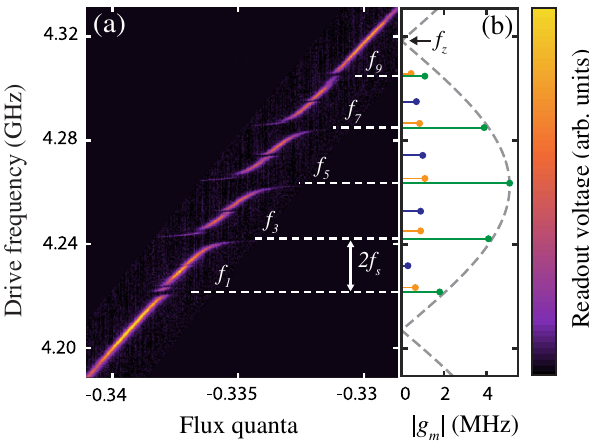
FIG. 2. Avoided crossings spectroscopy. Tuning the qubit across the cavity modes measures the mode frequencies and qubit-cavity coupling strengths. (a) Within the mirror bandwidth, 9 avoided crossings appear with varying coupling strength and a ¼ 10 . 6 MHz. The strong avoided nearly even mode spacing, f s crossings have a spurious mode on their high-frequency shoulder, which we attribute to a resonance with nonzero transverse mode number. (b) The coupling strengths to each mode are extracted from the measured crossings. The qubit couples more strongly to modes at the center of the mirror band with maximum strength g 0 ¼ 5 . 1 MHz. The IDT is symmetric about the cavity center, resulting in strong coupling to even modes (green) and weak coupling due to odd modes (blue). Coupling to transverse modes (orange) is a factor of 5 smaller. An inference of the frequency dependence of the qubit coupling strength (gray dotted line) made from measurements of the qubit spontaneous emission rate (see main text) agrees well with the measured coupling